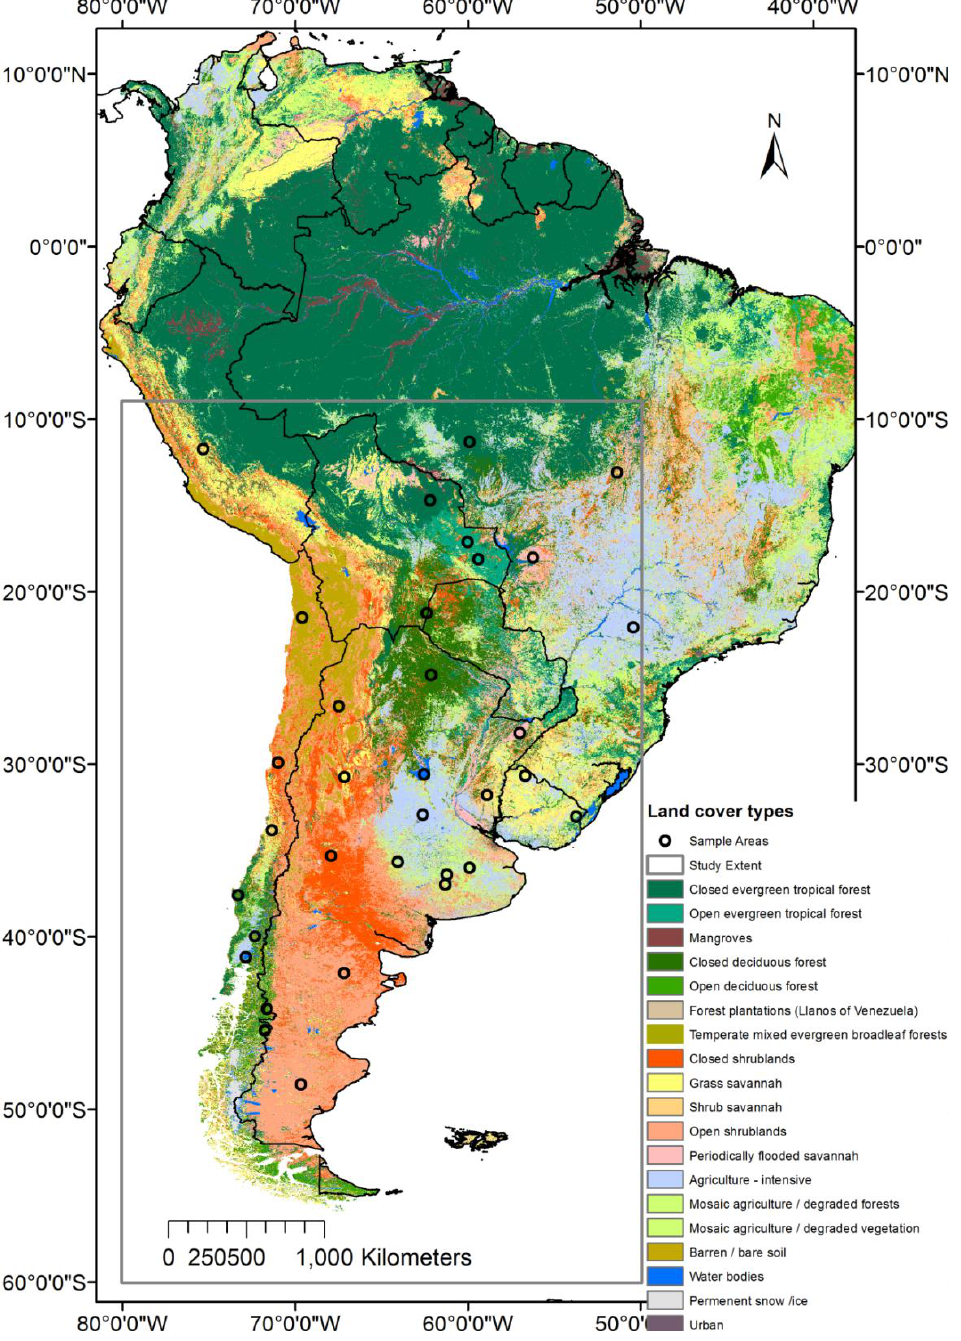
Figure 1. Land cover types based on data from Eva et al. [33]. The black circles are the sample areas representative of the major land cover types that are used to show the phenology and some examples of the seasonal and interannual NDVI time series data within the indicated study area